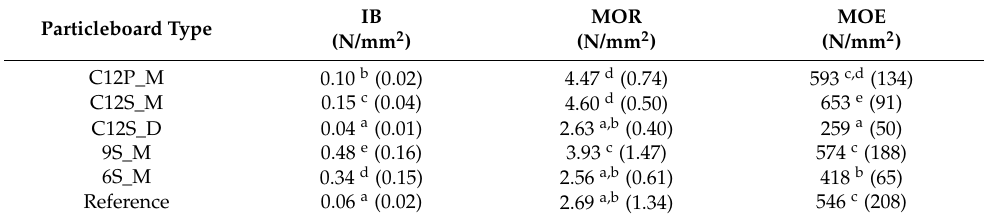
Table 3. Internal bond, modulus of rupture, and modulus of elasticity of the 10 mm particleboards with PS (values with the same letter (a,b,c,d,e) are not significantly different ANOVA, Post-Hoc Tukey HSD, p = 0.05; standard deviation in